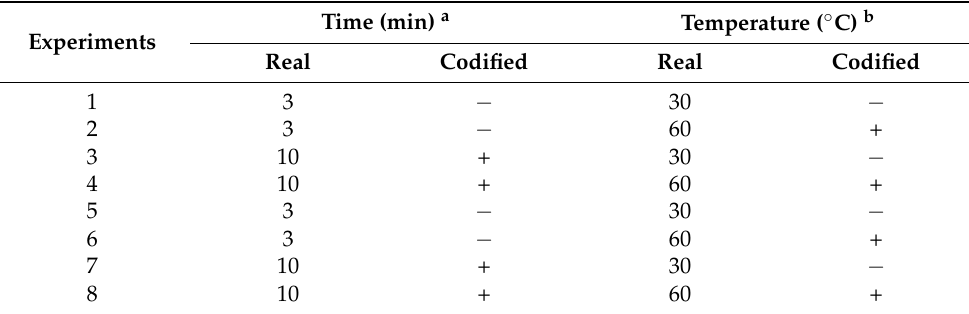
Table 1. Complete 2 2 -factorial design for optimization of the safrole extraction conditions from cowpea